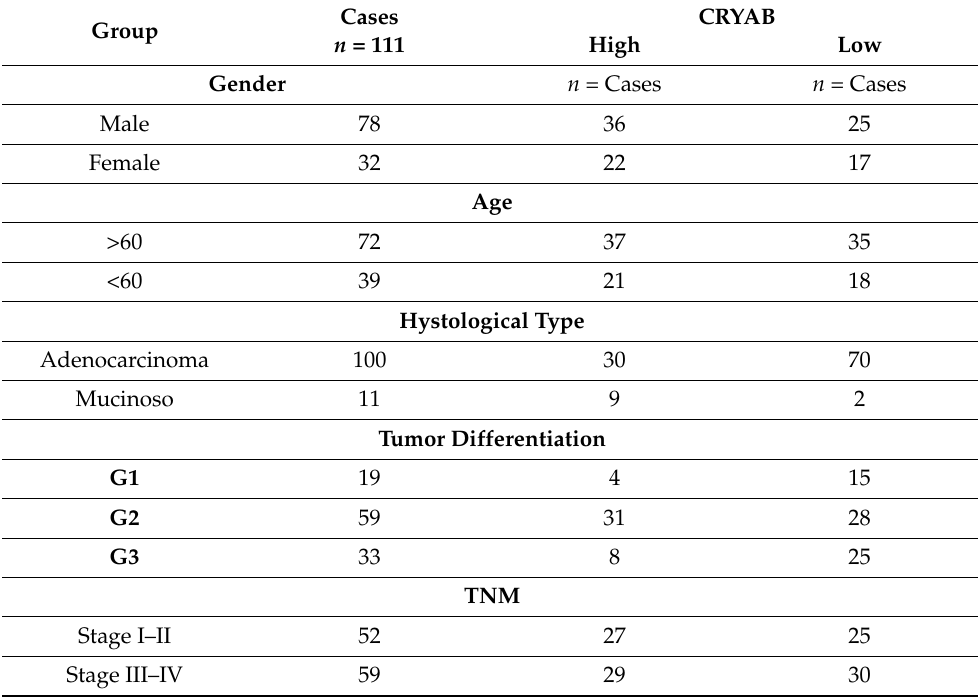
Table 1. Correlation of CRYAB expression with clinicopathological characteristics of 111 CRC patients.